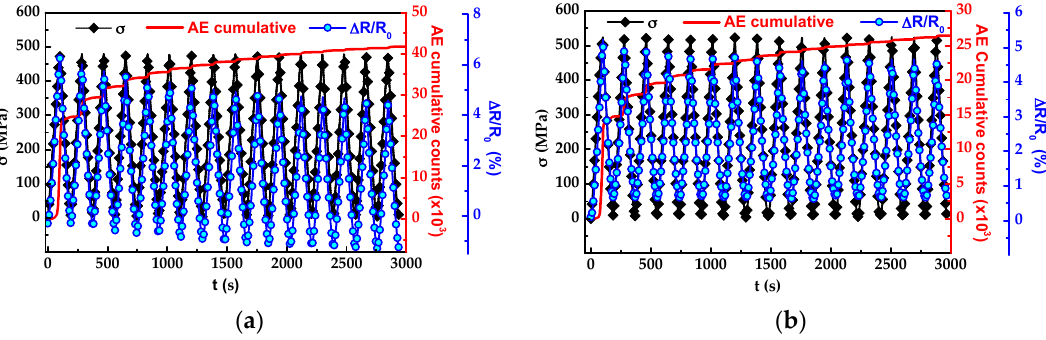
Figure 7. Evolution of stress (diamonds), ∆ R/R 0 (circles) and cumulative AE (red line) signals for a selected specimen subjected to cyclic loading. ( a ) Composite with architecture m , and ( b ) composite with architecture f .